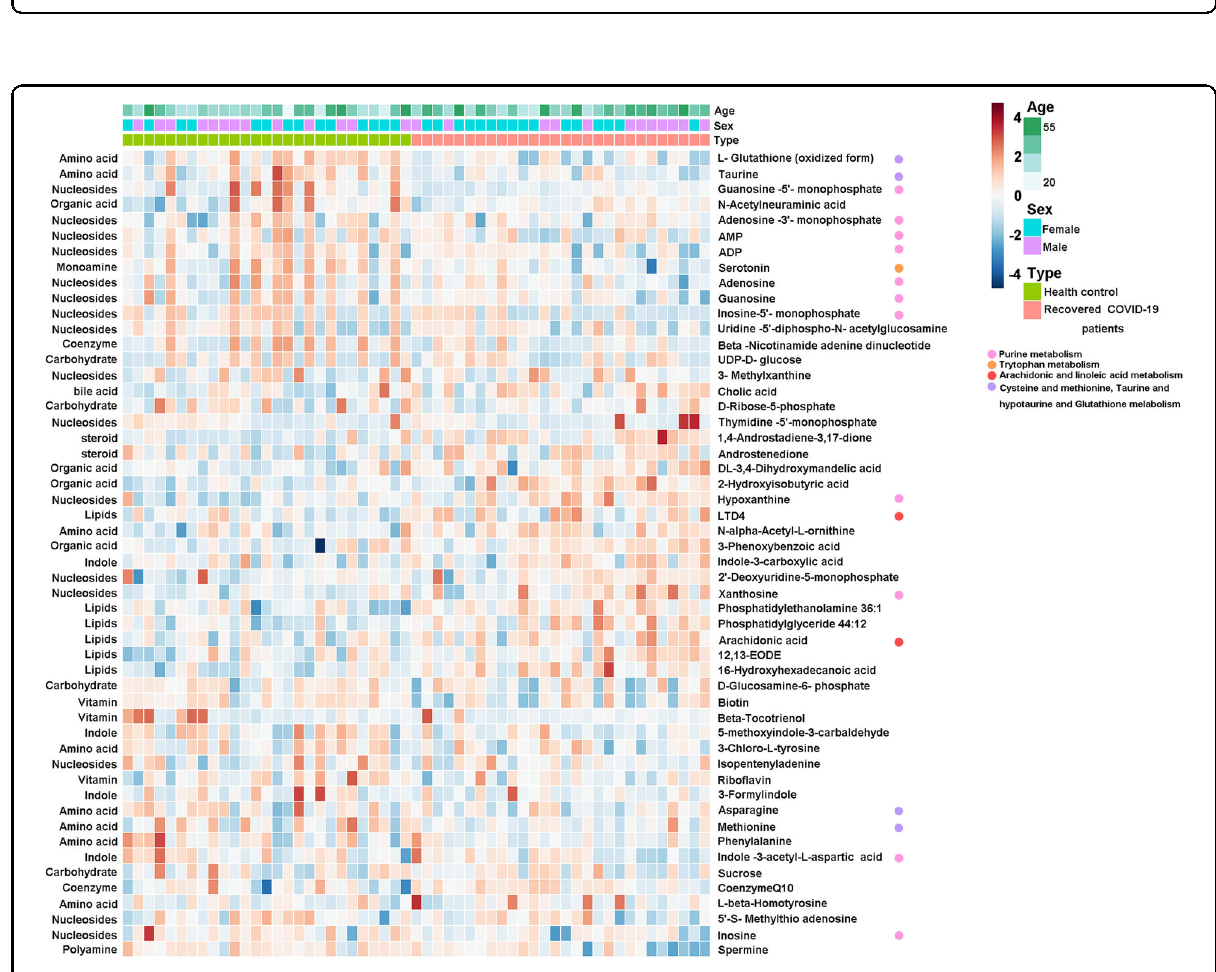
Fig. 3 Differential plasma metabolites revealed in recovered COVID-19 patients when compared with healthy controls. Heat map of 52 differential metabolites from 12 major classes in recovered COVID-19 patients, metabolites levels were displayed by the shades of the color (red and blue present lower level, and higher level,